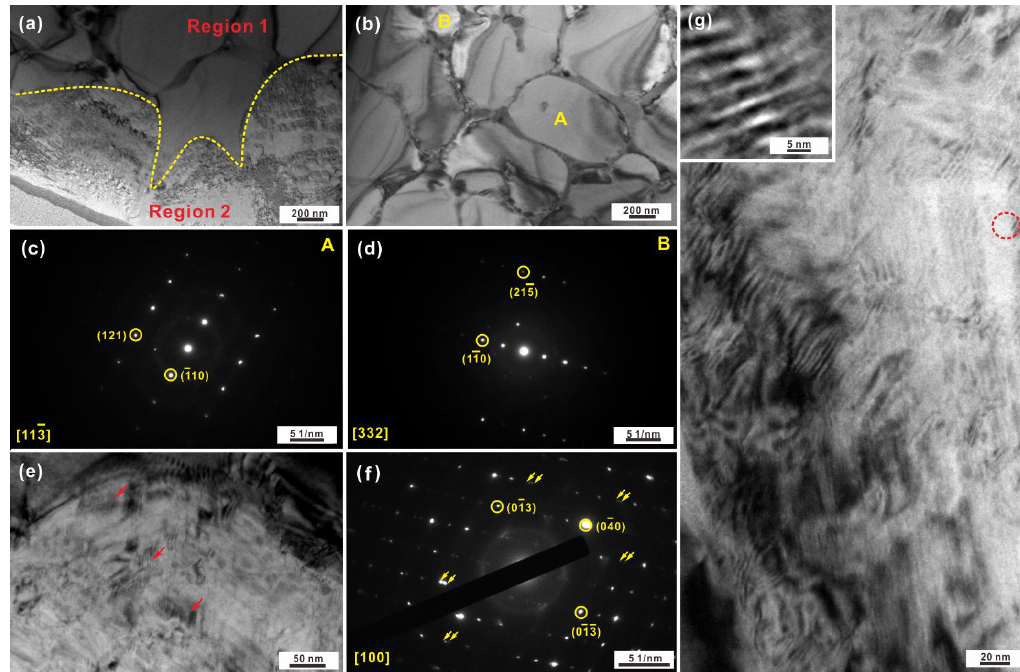
Figure 4. ( a ) Transmission electron microscopy (TEM) image of the T1 sample; ( b ) local enlarged image of region 1, selected area electron diffraction (SAED) patterns of particles; ( c ) particles A and ( d ) particles B; ( e , g ) local enlarged images of region 2 and the corresponding ( f ) SAED pattern.